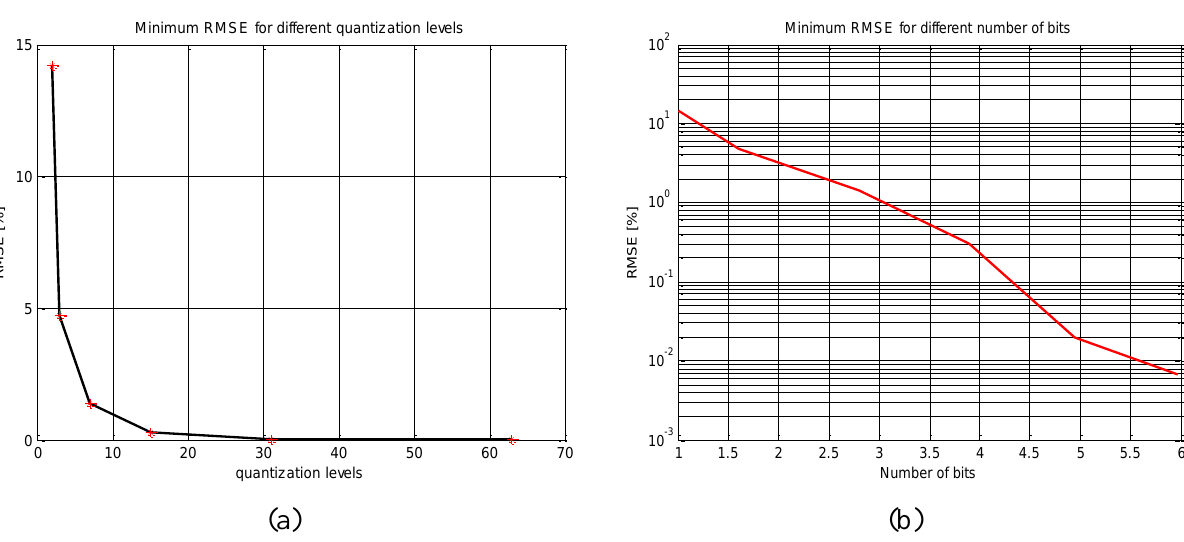
Figure 4. Minimum root mean square errors for different quantization levels, it decreases following an exponential trend, (a) RMSE decreasing vs . the quantization levels, and (b) RMSE in a semi-log axis decreasing vs . the number of